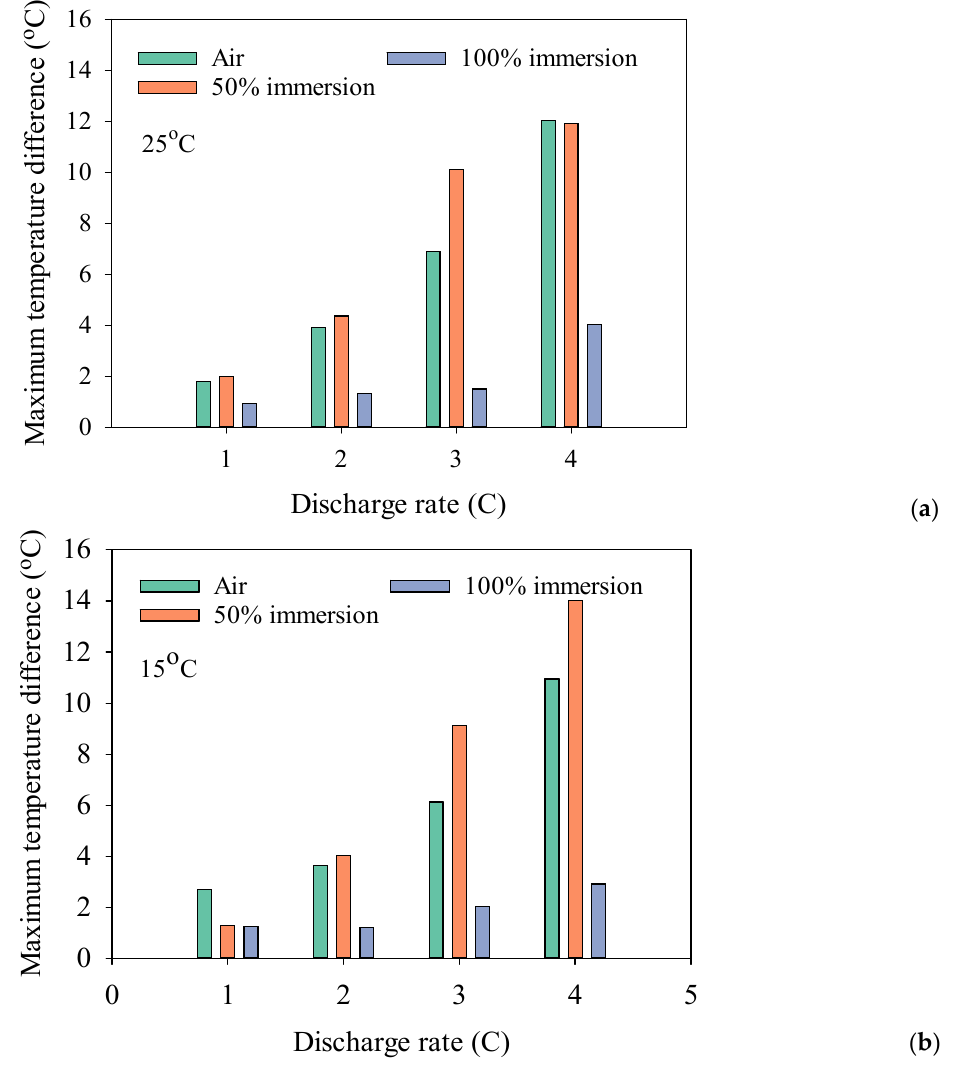
Figure 8. Maximum temperature differences at the end of different discharge rates for ( a ) T inlet = 25 °C and ( b ) T inlet = 15 °C.